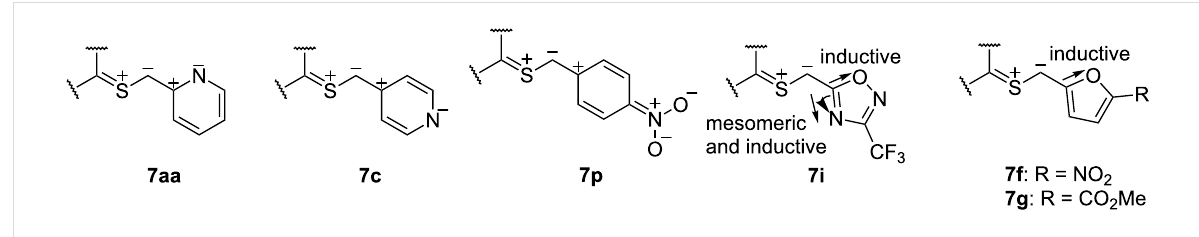
Figure 4: The proposed structure of sulfur ylide-like intermediates; resonance contributors (mesomeric structures) [69-72,78].